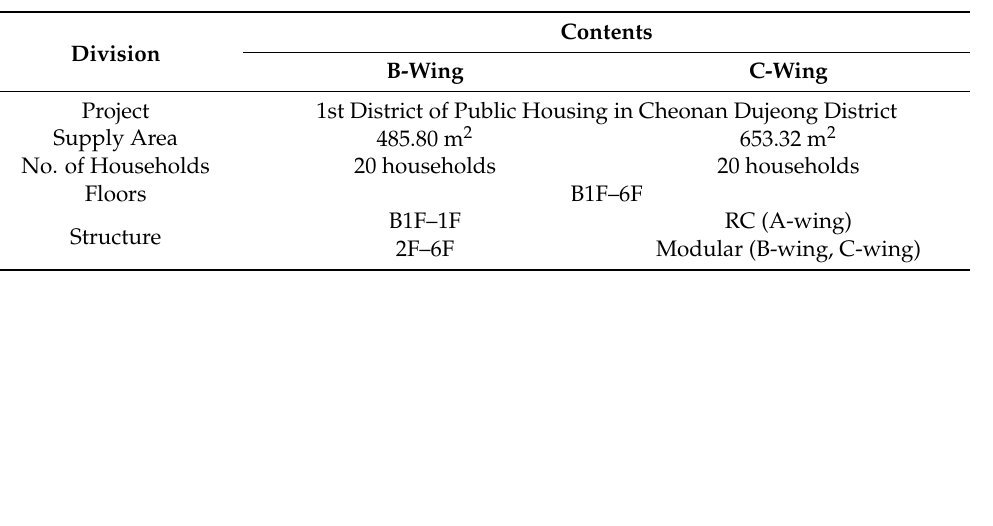
Table 1. Project